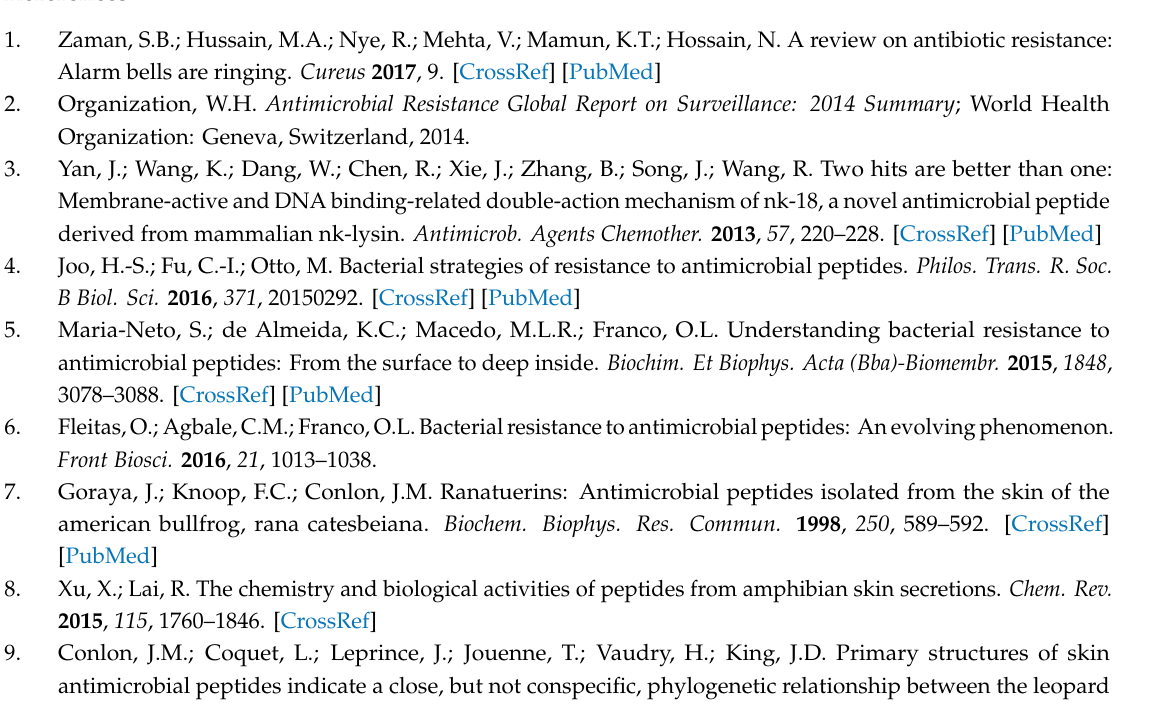
Supplementary Materials: The following are available online at http: // www.mdpi.com / 2218-273X / 9 / 6 / 249 / s1, Figure S1. Nucleotide and corresponding translated open-reading frame of precursor cDNA cloned from the skin secretion of Chinese piebald odorous frog cDNA library that encodes ranatuerin-2Pb. Figure S2. RP-HPLC chromatogram and mass spectrums of synthesised peptides, ranatuerin-2Pb (a), RPa (b) and RPb (c). Author Contributions: Conceptualization, M.Z., L.W., T.C. and H.F.K. Formal analysis, C.M., X.X. and H.F.K. Funding acquisition, R.Z. and H.F.K. Investigation, X.Z. and D.S. Methodology, C.M. and X.X. Resources, D.S. and R.Z. Supervision, X.X. Validation, X.Z., Z.Y., M.Z. and X.X. Writing—original draft, X.Z. and D.S. Writing—review & editing, X.X., T.C. and